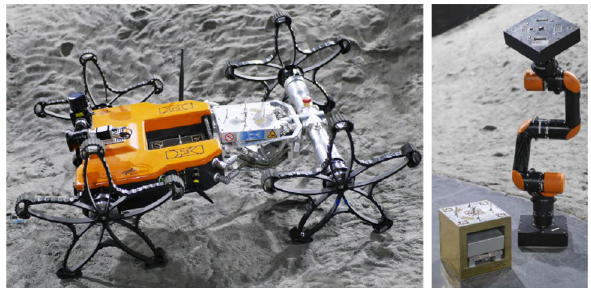
Fig. 1 Example of a modular robotic system, consisting of mobile robot Coyote III , manipulator arm, and payload modules, which can attach to each other using an electro-mechanical interface (EMI). One of the two EMIs of Coyote III provides additional 2 DOFs [10, 37]